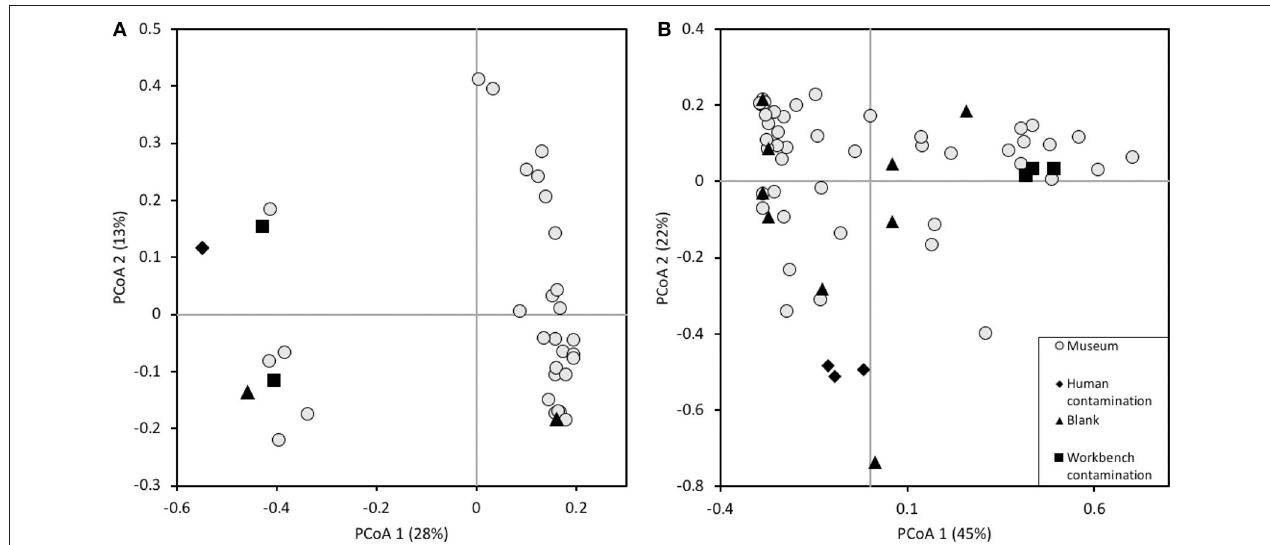
FIGURE 2 | Principal Coordinate Analysis (PCoA) of (A) microbiome composition in the gut and (B) prey item composition in the stomach of Antarctic Trematomus fish from natural history museum (gray) and control samples